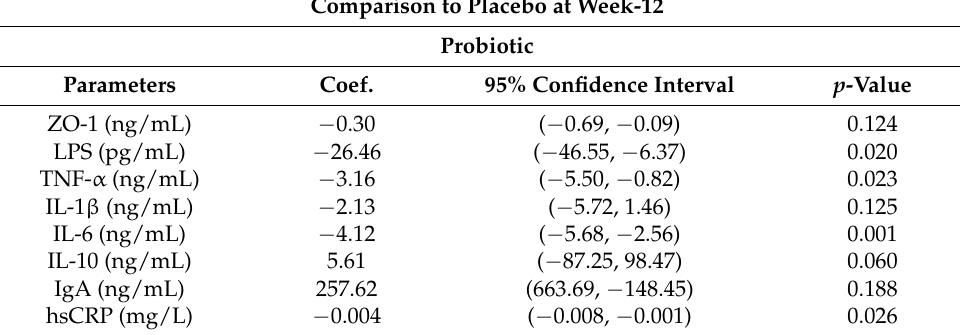
Data are mean ± SD. Significant difference between groups at the end of study. p -values obtained from linear regression after adjusting for baseline characteristics and baseline of the corresponding parameter. Coefficient (Coef.) is defined as the difference in outcome measures between probiotic and placebo groups.